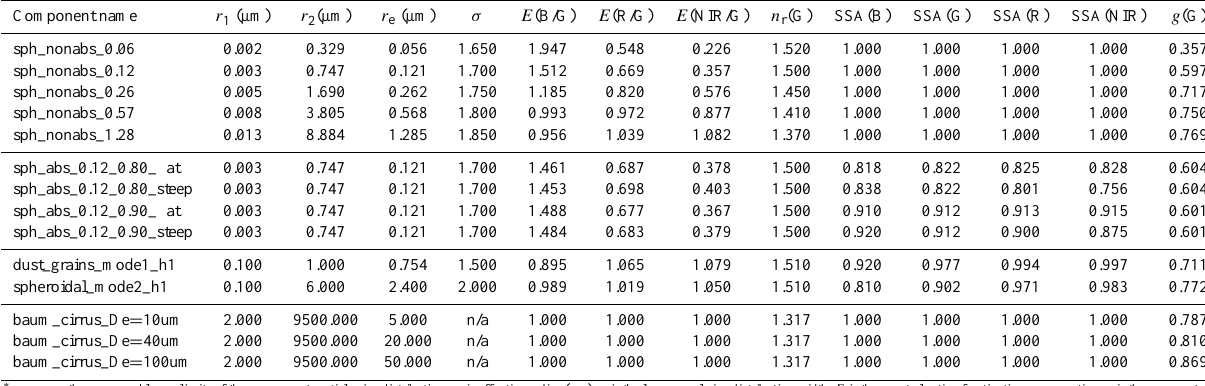
Figure 6. Real part of refractive index sensitivity study. The top four panels show the fractional change in retrieved AOD for an atmo- sphere containing 1.28 micron non-absorbing particles with n r = 1.37, when the comparison space contains the same size particles but with n r = 1.45, for 558nm AOD values of 0.05, 0.20, 0.50, and 2.0. The bottom four panels present the χ 2 trieved AOD for the same four AOD values. As values vary with retrieval geometry, results are plotted for an illustrative orbit, orbit 70499, 20 March 2013. Over-water conditions are assumed everywhere, with the surface pressure prescribed as 1013.25mb, and the surface wind speed set to 2.5ms − 1 . A more extensive analysis of n r sensitivity, covering a range of particle sizes, is given in the Supplement. Table 4. MISR components for the 774-mixture set ∗